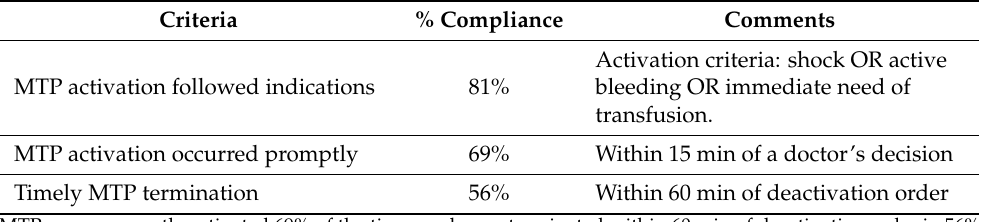
Table 2. Timely activation and termination of MTP.